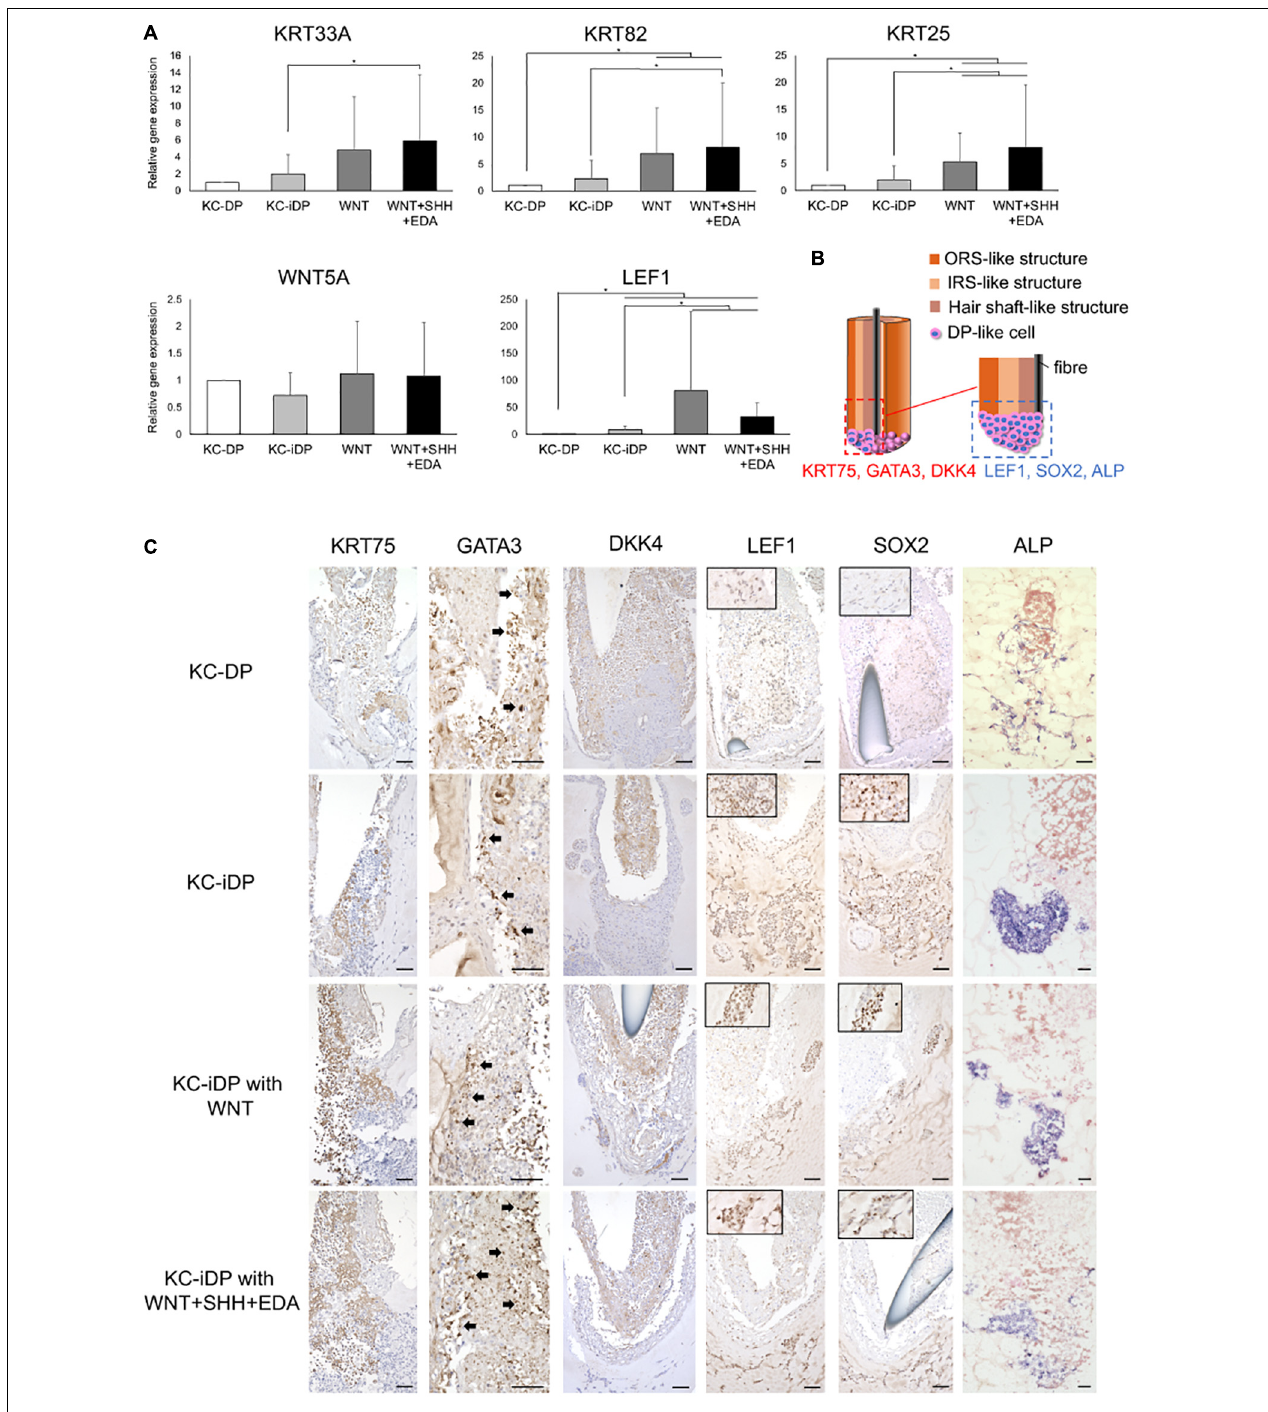
FIGURE 6 | KC-iDP constructs responded to WNT, SHH, and EDA agonists to upregulate HF-related markers. (A) A WNT agonist increased HF keratin gene and LEF1 expression in KC-iDP constructs, which was further enhanced by the simultaneous activation of WNT, SHH, and EDA signaling pathways (Mean ± SEM; n = 5, triplicate for each experimentation; * p < 0.05, Wilcoxon signed-rank test). (B) The schema illustrating the intratissue distribution of examined hair follicle markers within KC-iDP constructs. (C) Immunoreactivities for hair follicle epithelial (KRT75, GATA3, and DKK4) and mesenchymal (LEF1, SOX2, and ALP) markers in non-treated, WNT agonist-treated, and triple agonist-treated KC-iDP constructs in comparison to those in KC-DP constructs. KRT75, SOX2, and LEF1 immunoreactivities were more intense in KC-iDP constructs, when compared to those in KC-DP constructs. Scale bar: 200 µ m. ALP, alkaline phosphatase; DKK4, dickkopf 4; DP, dermal papilla; GATA3, GATA binding protein 3; iDP, keratinocyte-human induced pluripotent cell-derived dermal papilla substituting cell aggregate; KC, keratinocyte; KRT, keratin; LEF1, lymphoid enhancer binding factor 1; SOX2, sex determining region Y-box 2.